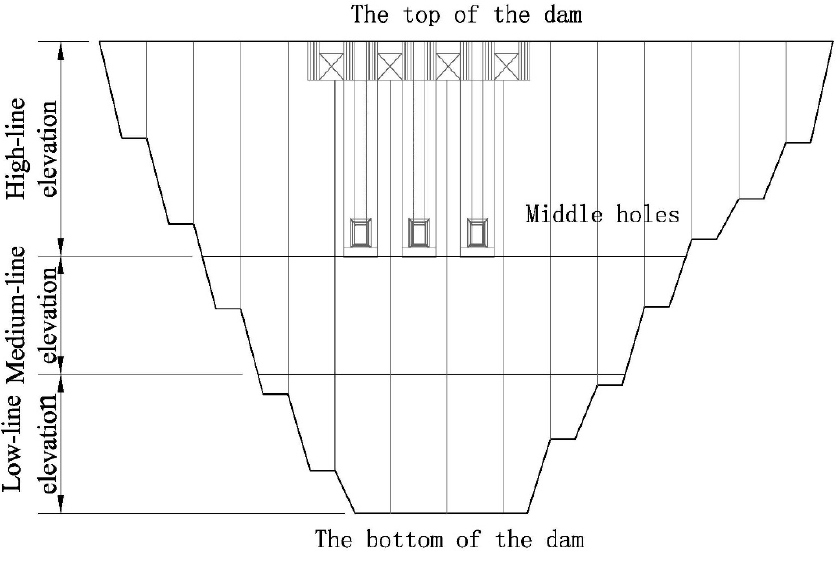
Figure 5. Schematic diagram of the demarcation of the dam body. High-line elevation: usually from the bottom of the middle hole to the top of the dam. Medium-line elevation: usually from the cofferdam elevation to the bottom of the middle